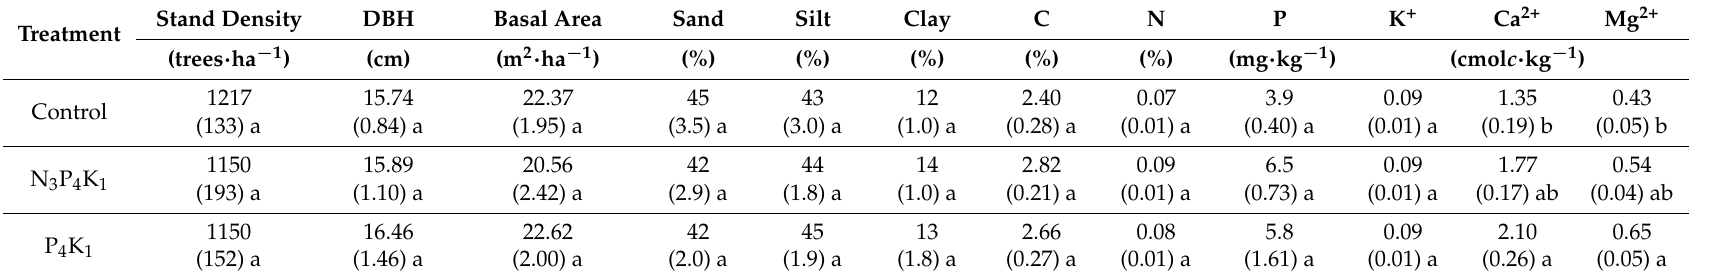
Table 1. General stand and soil characteristics of the study site before fertilizer application.